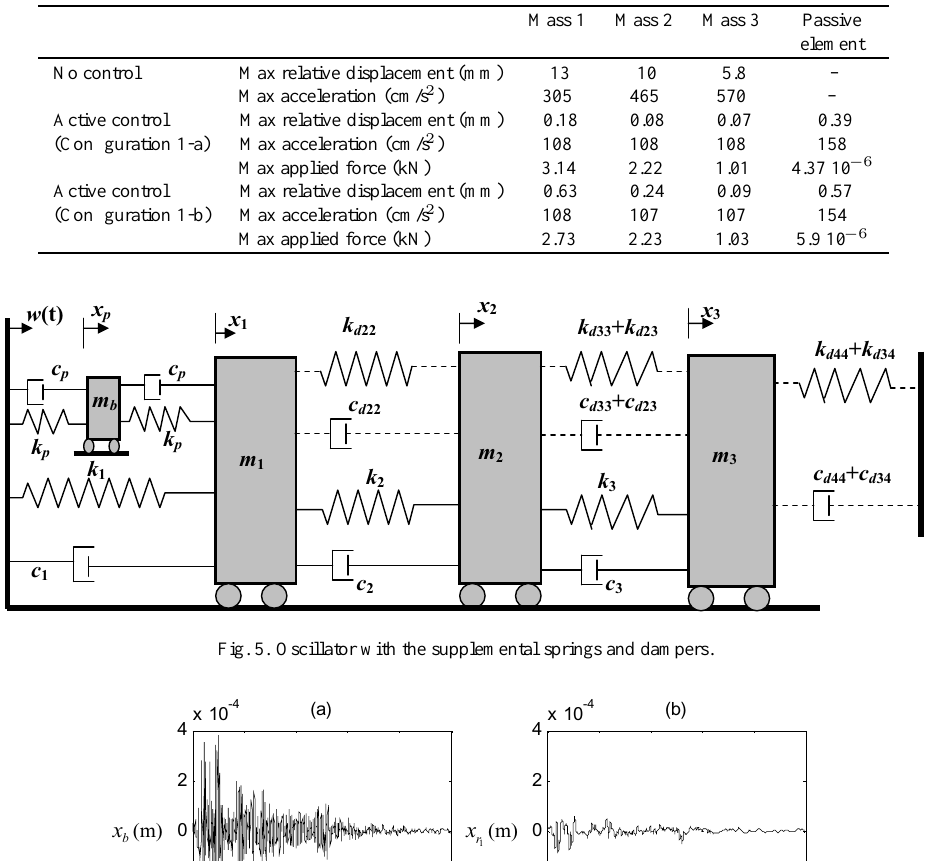
Table 2 Different parameters and performance indices of the controlled and uncontrolled systems